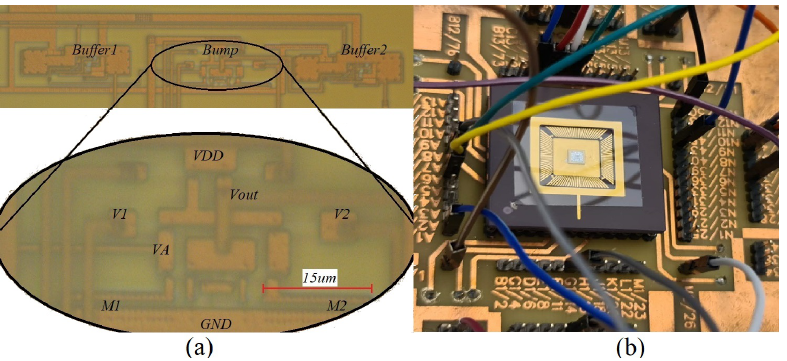
Figure 15. ( a ) Micrograph of the chip produced using the 350 nm CMOS from AMS. Each node named in the picture is according the circuit shown in Figure 8a. Buffer1 is connected to VA and Buffer2 to Vout. ( b ) the measurement setup on